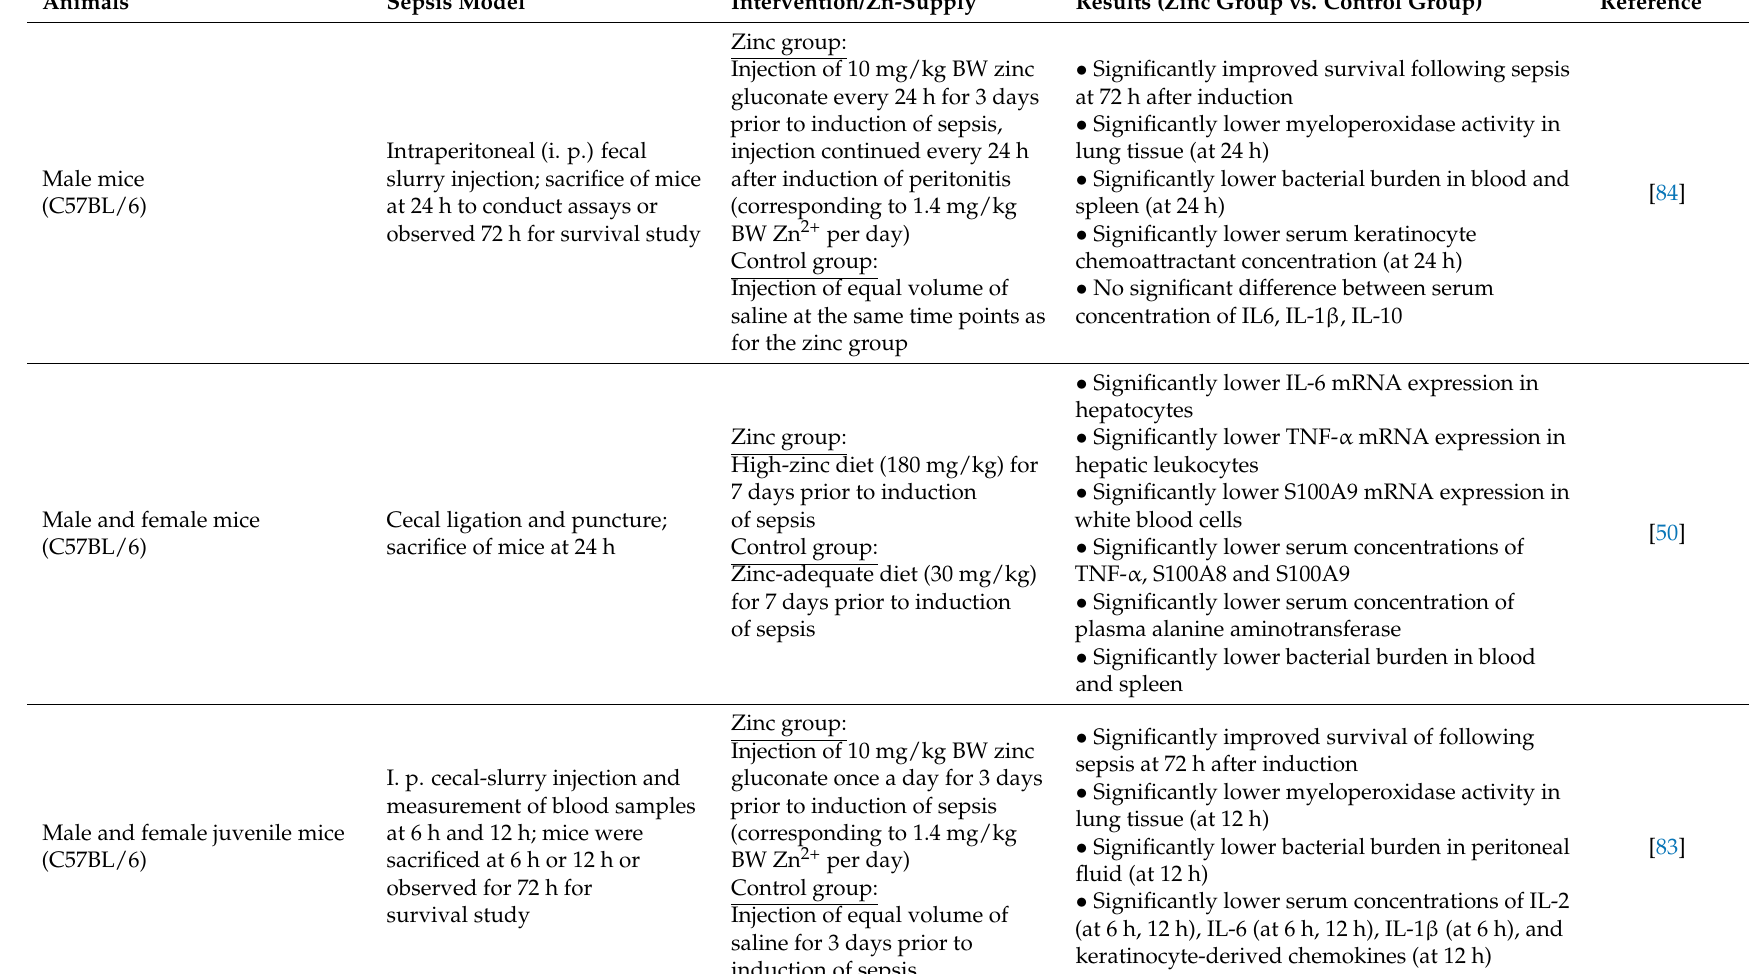
Table 2. Zinc supplementation studies in animal models of sepsis. LPS: